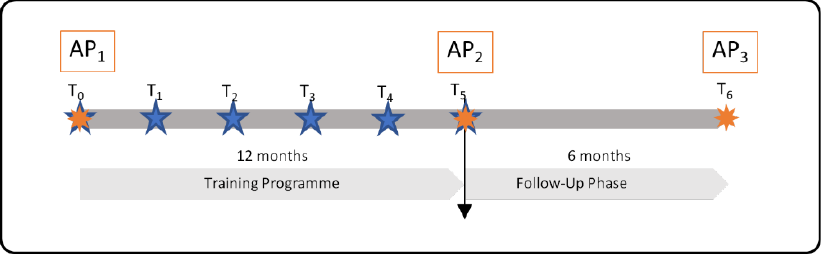
Figure 6. Training Timeline and Assessment Points. T 0–5 : Training Modules, AP 1–3 : Assess- ment Points.